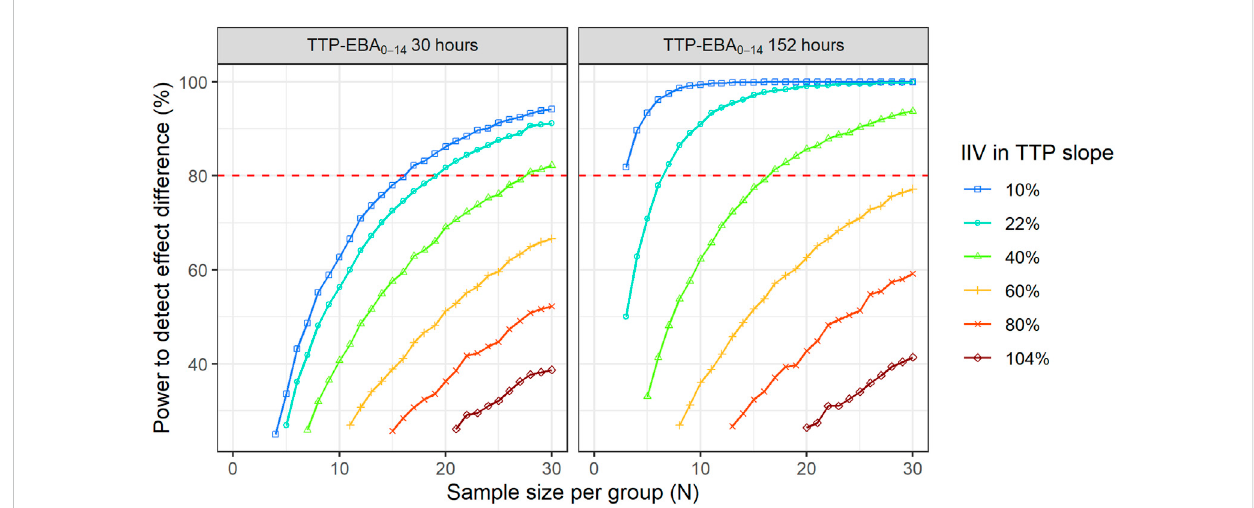
FIGURE 11 The impact of inter-individual variability (IIV) in early bactericidal activity (EBA) on the sample size and power to detect a difference between two treatment groups. The effect difference between the two treatment groups was set to 50%. The red dashed line represents 80%